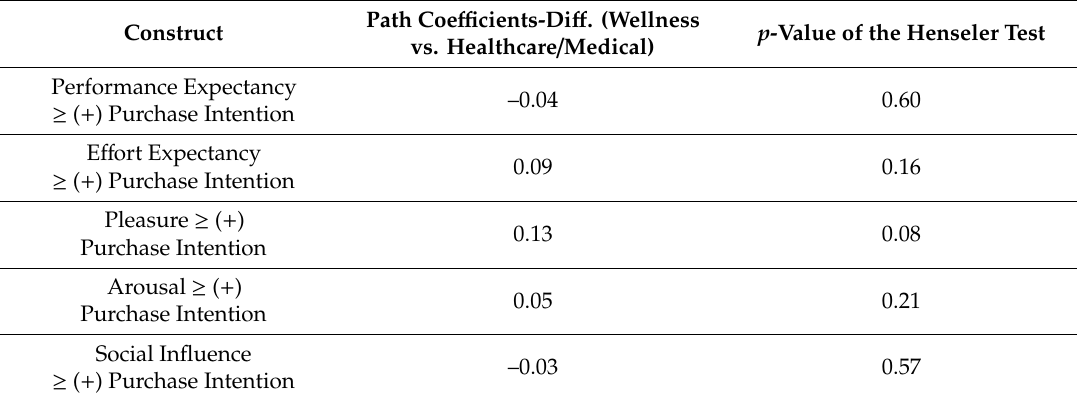
Table 5. Multigroup